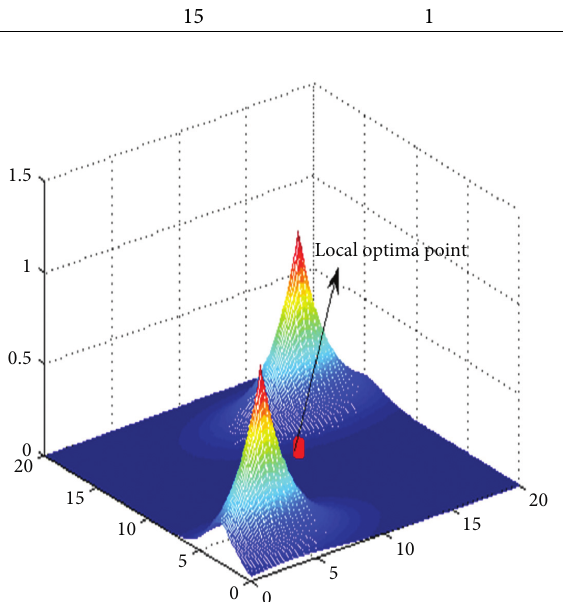
Figure 8: Local optima point problem.